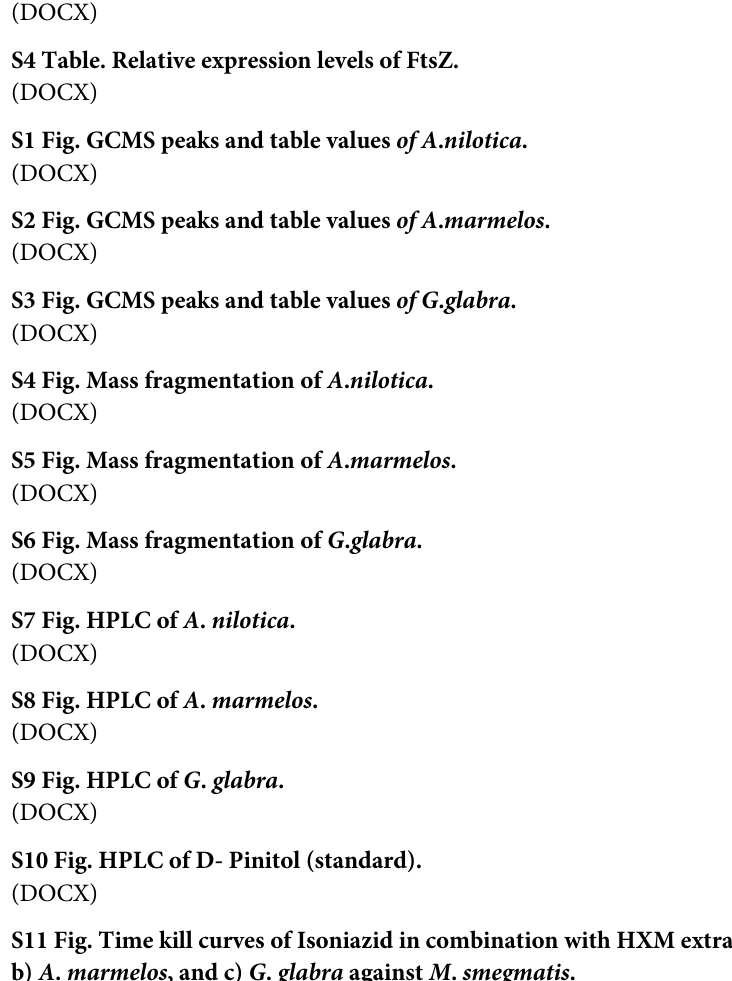
(DOCX) S3 Table. List of primers used in the FtsZ gene expression study. (DOCX) S4 Table. Relative expression levels of FtsZ. (DOCX) S1 Fig. GCMS peaks and table values of A . nilotica . (DOCX) S2 Fig. GCMS peaks and table values of A . marmelos . (DOCX) S3 Fig. GCMS peaks and table values of G . glabra . (DOCX) S4 Fig. Mass fragmentation of A . nilotica . (DOCX) S5 Fig. Mass fragmentation of A . marmelos . (DOCX) S6 Fig. Mass fragmentation of G . glabra . (DOCX) S7 Fig. HPLC of A . nilotica . (DOCX) S8 Fig. HPLC of A . marmelos . (DOCX) S9 Fig. HPLC of G . glabra . (DOCX) S10 Fig. HPLC of D- Pinitol (standard). (DOCX) S11 Fig. Time kill curves of Isoniazid in combination with HXM extracts of a) A . nilotica , (DOCX) S12 Fig. Time kill curves of rifampicin in combination with HXM extracts of a) A . nilotica ,